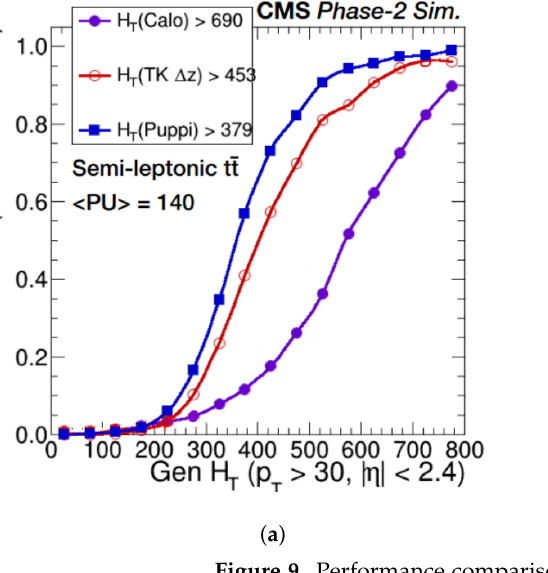
Figure 9. Performance comparison between standalone calorimeter trigger hadronic objects and objects built using the PFlow and PUPPI algorithms: ( a ) Trigger efficiency at fixed L1 rate as a function of generator-level H T . The corresponding L1 H T thresholds are referenced in the legend; ( b ) Trigger efficiency at fixed L1 rate as a function of the generated jet’s p T . The corresponding L1 p T thresholds are referenced in the legend.